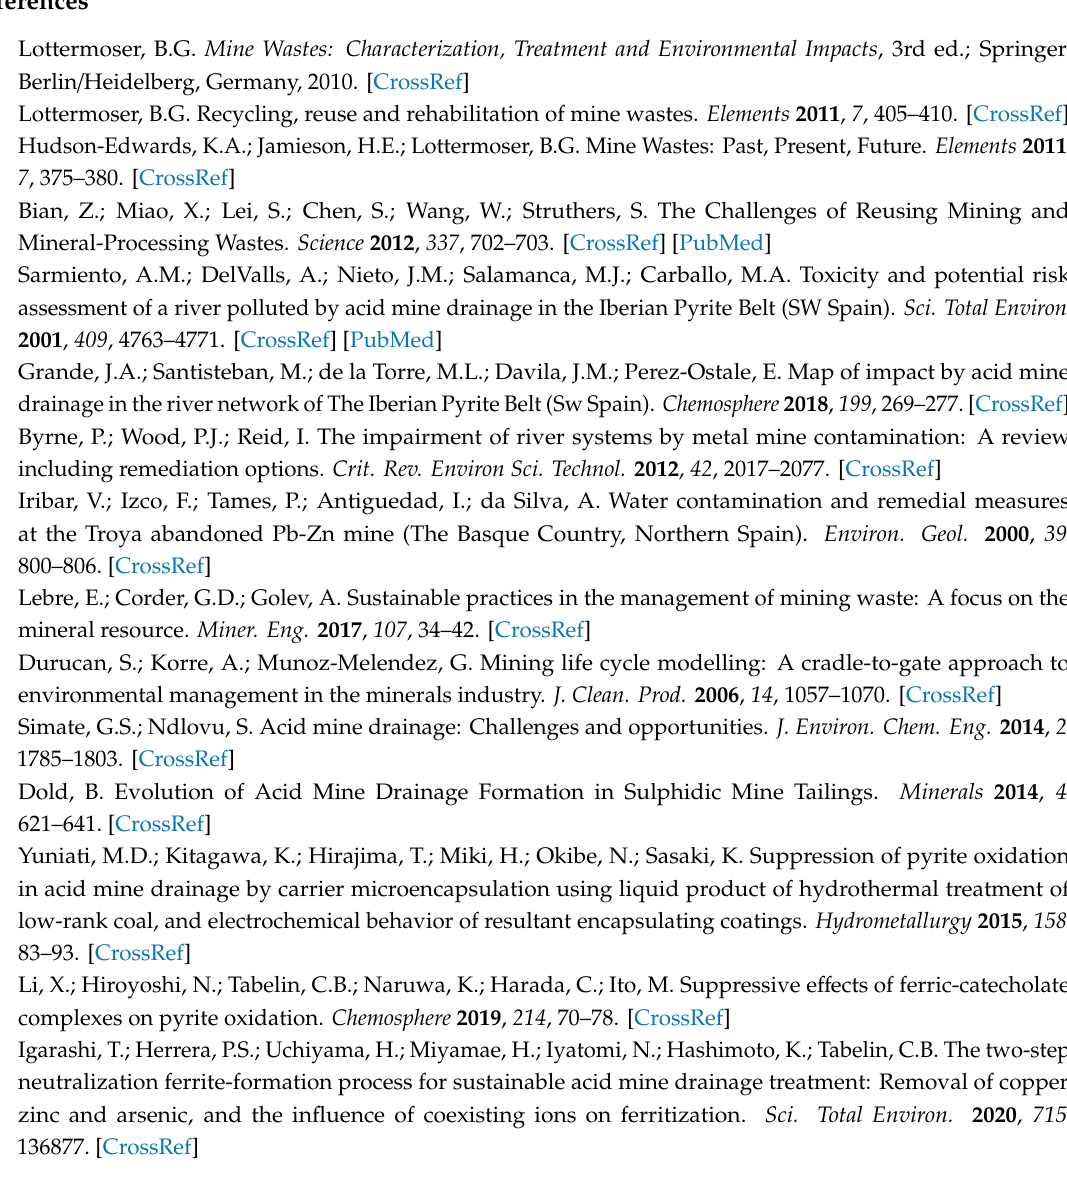
Figure S1: Evolution of selected parameters in acid mine drainage (AMD) with temperature data. Table S1: Monitoring results of AMD, Table S2: Monitoring results of tailings, Table S3: Titration of tailings using acid mine drainage (collected in February and April) from the